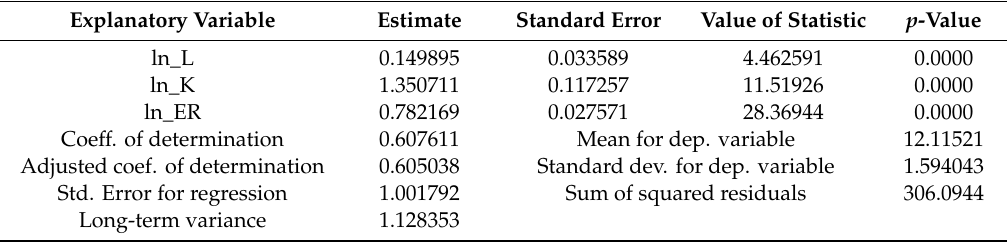
Table 3. Panel data model based on fully modified ordinary least squares method (FMOLS) estimators to explain output growth in the EU countries and UK (2007–2019).